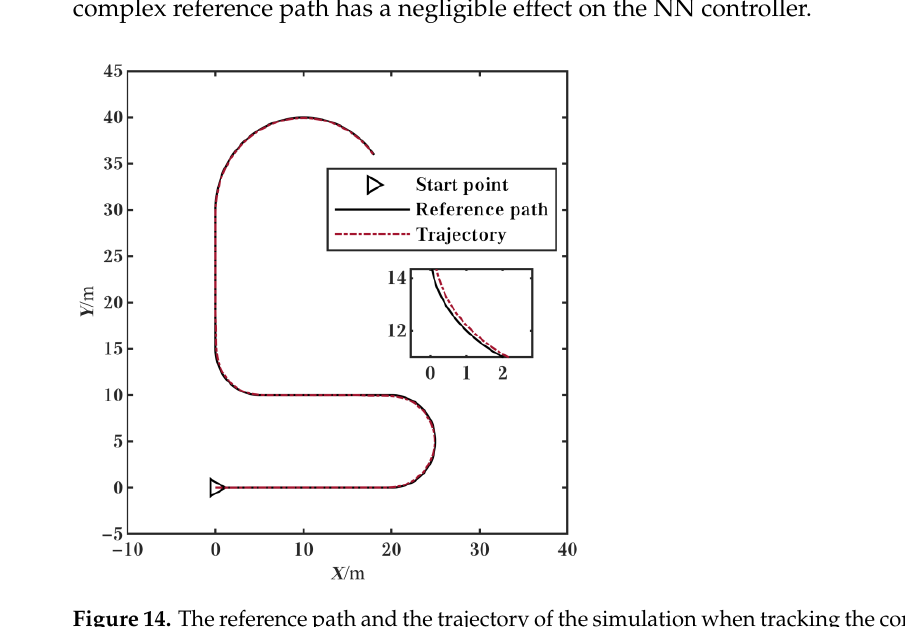
Figure 14. The reference path and the trajectory of the simulation when tracking the complex reference path.